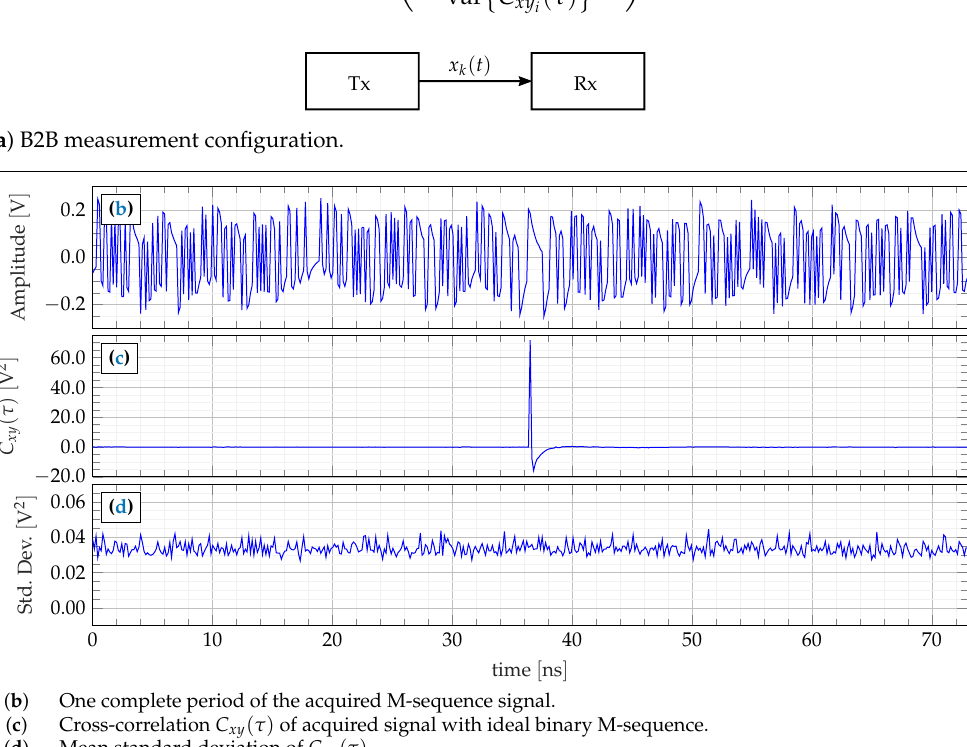
Figure 13. Signal peculiarities of the M-sequence signal measured in back-to-back (B2B) configuration: 9th-order M-sequence driven at f 0 =